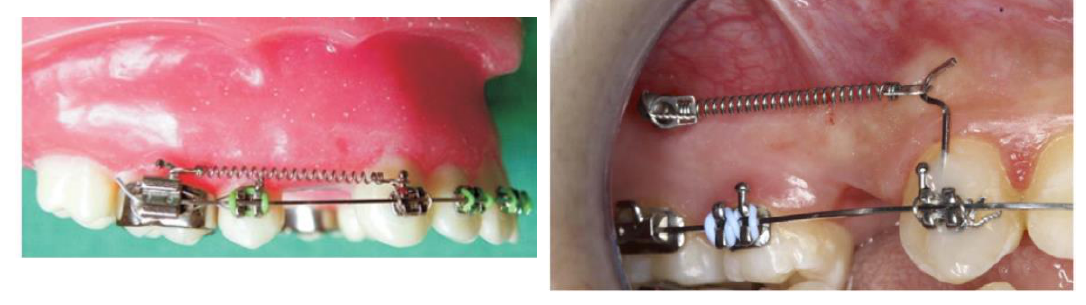
Figure (8): Canine retraction using NiTi closed